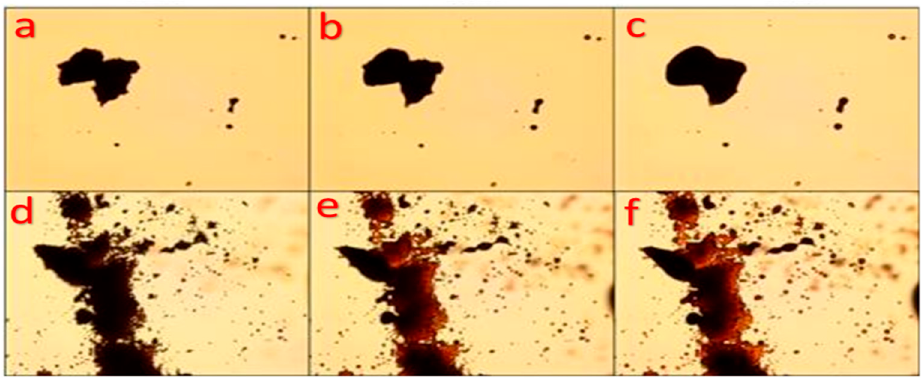
Figure 5. Optical microscopy (20×) images of PB ( a – c ) and PAV ( d – f ) asphaltenes at high temperature.